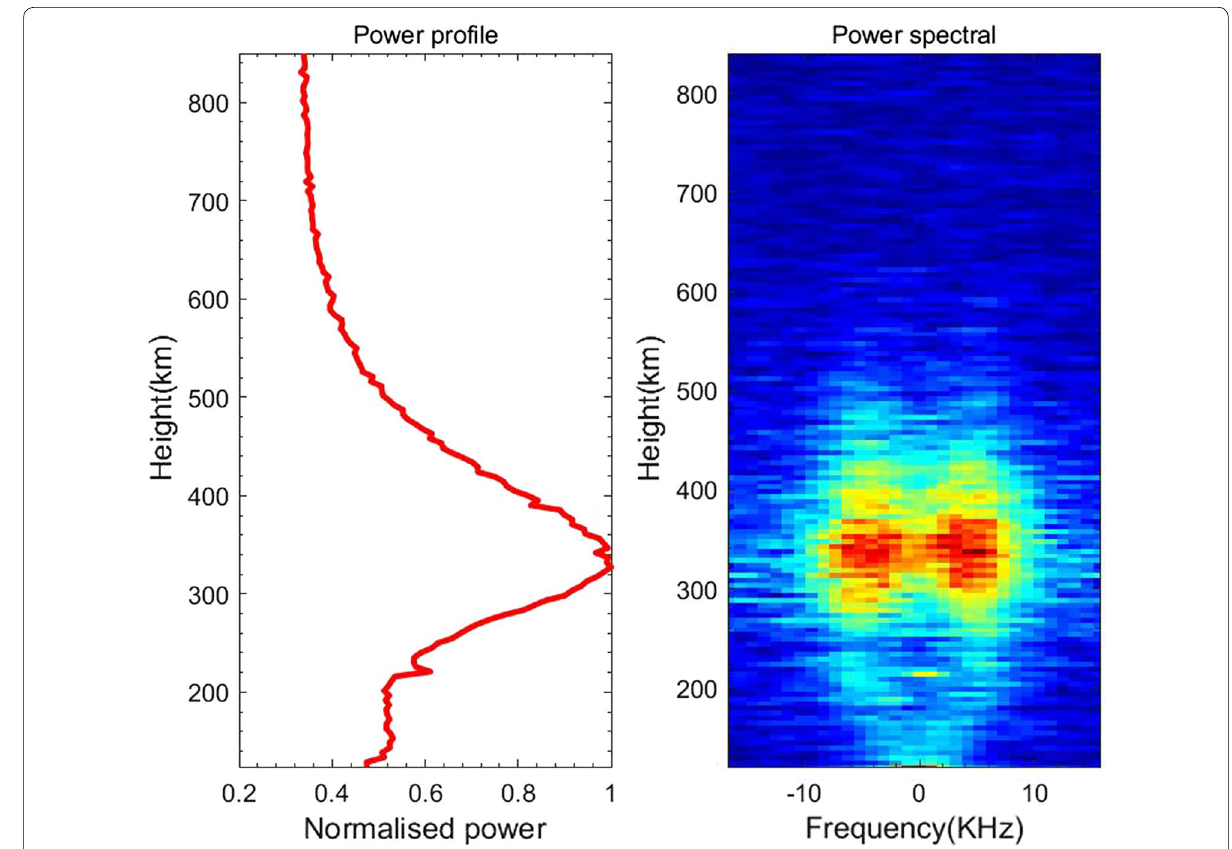
Fig. 10 An example of the measured echo profile (left) and spectra